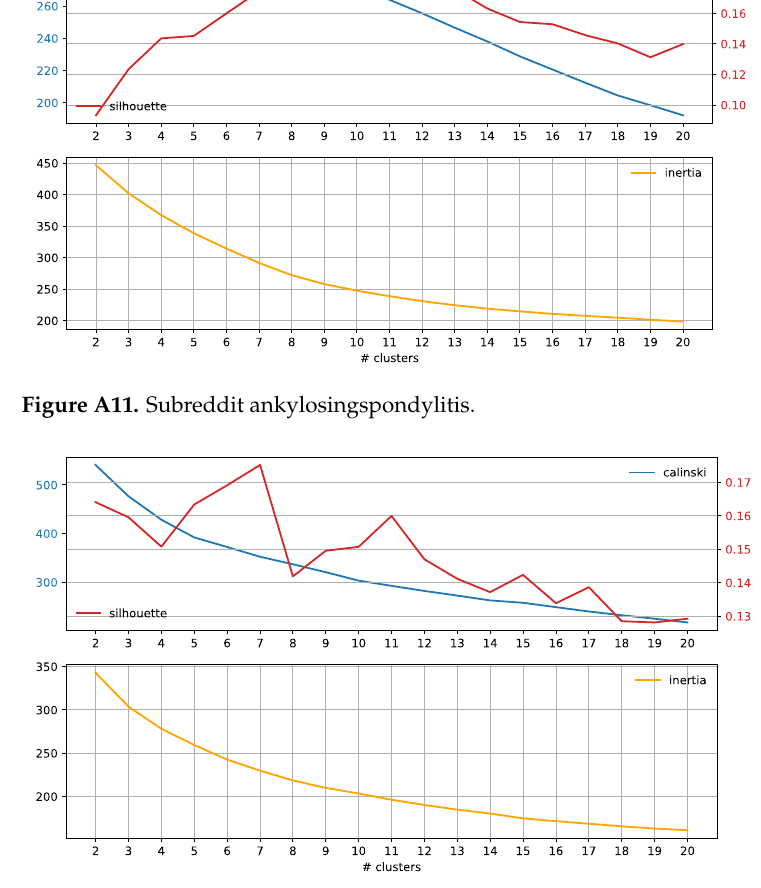
Figure A12. Subreddit backpain.